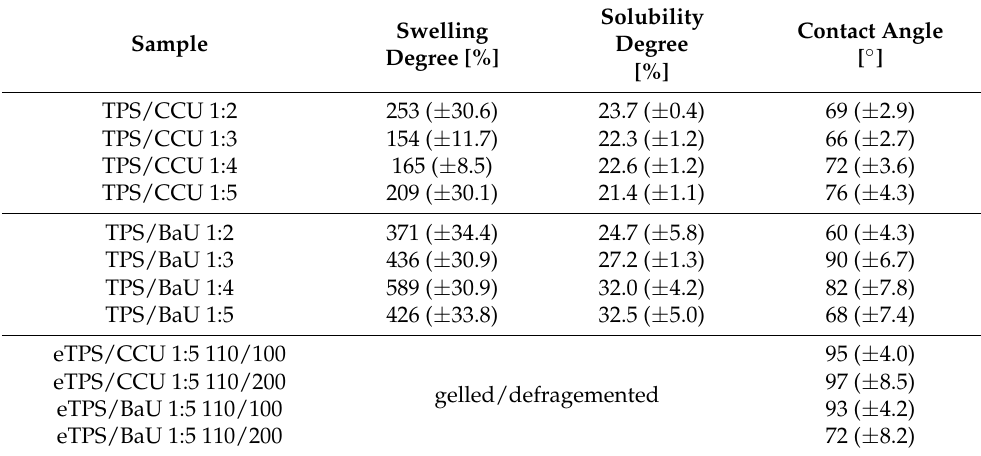
Table 4. Swelling and solubility degrees as well as surface contact angle values of TPS films obtained via thermocompression (TPS) and extrusion and then thermocompression (eTPS).